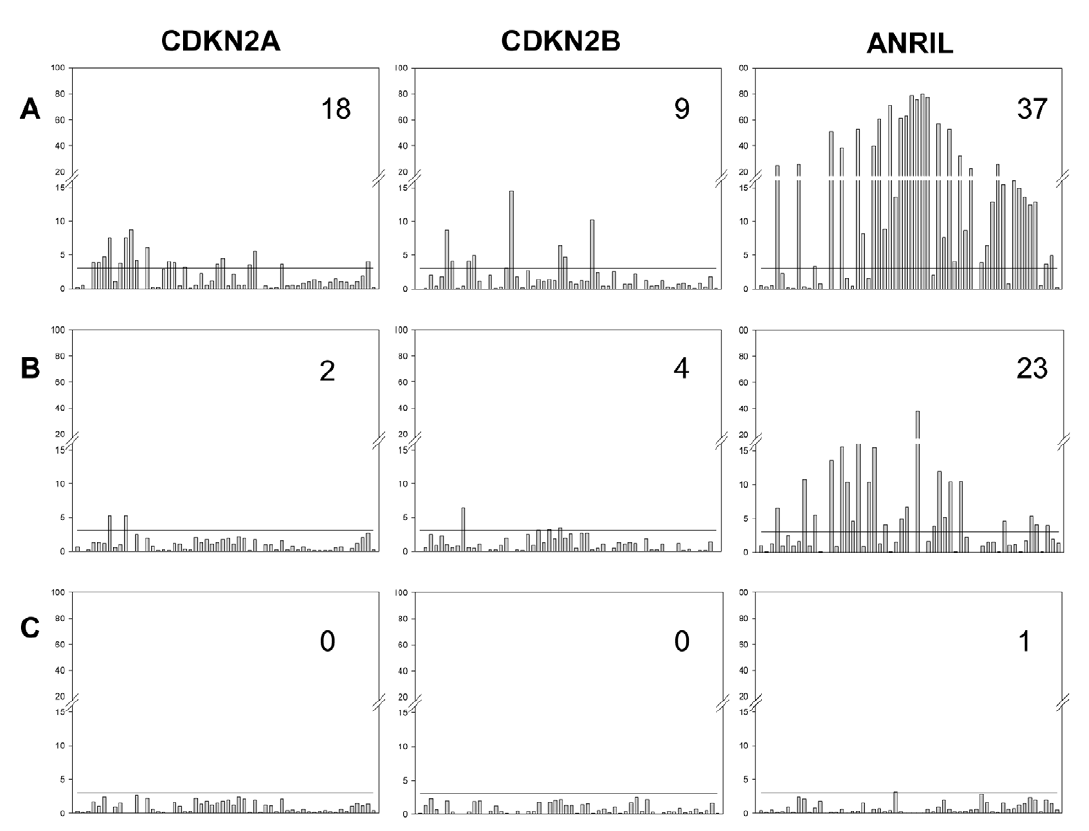
Figure 5. Effect of sequential adjustment for most highly associated SNPs. Bars represent the significance of association ( 2 log 10 P) for each SNP. (A) Unadjusted. (B) Adjusted for the most highly associated SNP for each gene ( CDKN2A rs7036656, CDKN2B rs3218018, ANRIL rs564398). (C) Adjusted for the two most highly associated SNPs for each gene ( CDKN2A rs7036656 and rs36228834, CDKN2B rs3218018 and rs3814960, ANRIL rs564398 and rs10965215). Values in the top right corner are the number of significantly associated SNPs after each round of adjustment, following correction for multiple testing. The horizontal black line on each graph represents the significance threshold after adjustment for multiple testing (family wise error rate of 0.05 corresponding to 2 log 10